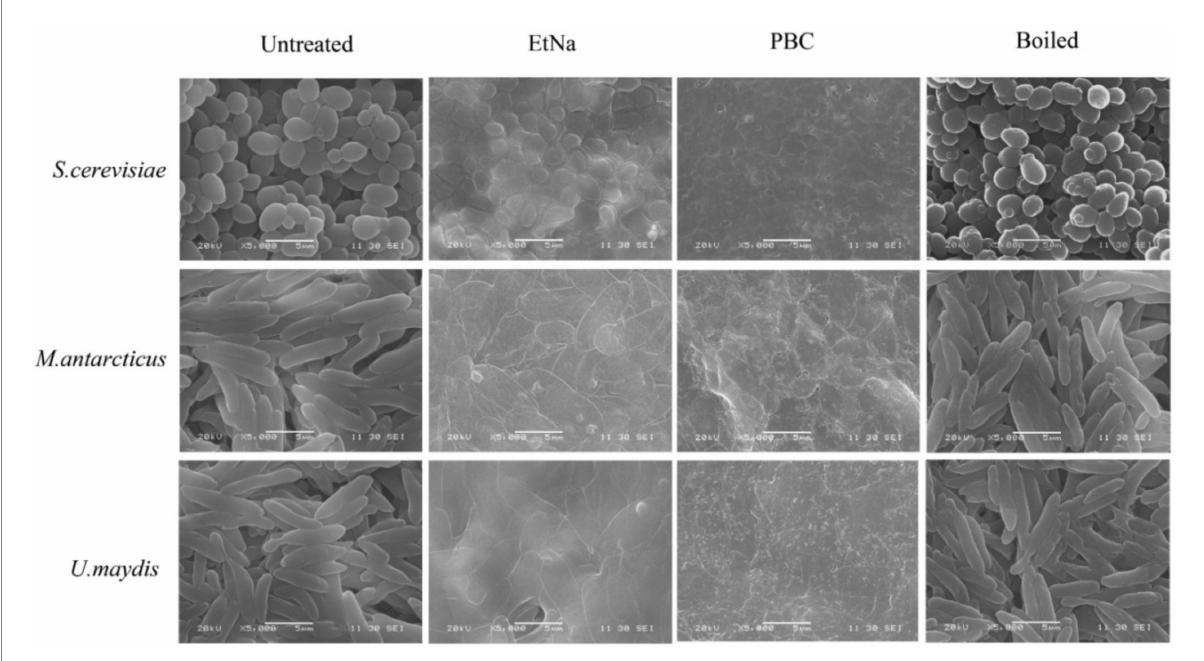
FIGURE 5 Scanning electron microscopy analysis of cell states after different treatments. Scan images show cells of S. cerevisiae , M. antarcticus and U. maydis after 100 ° C water bath (boiled), PBC and EtNa treatments. Untreated cells were used as